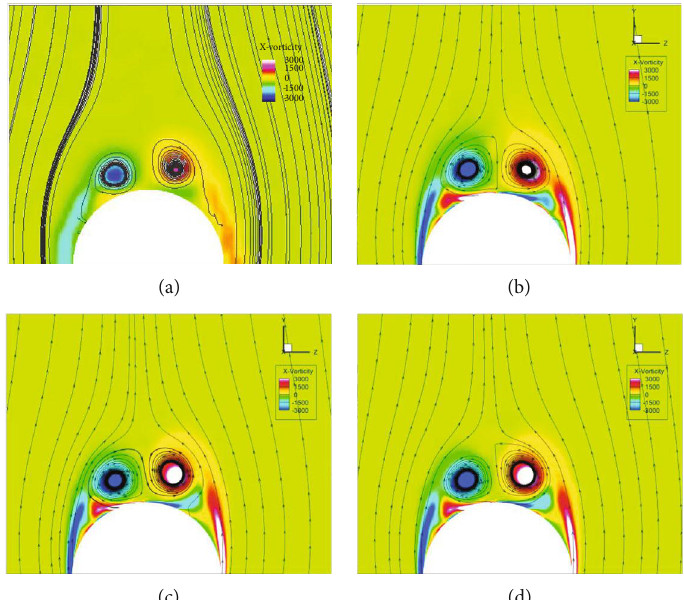
Figure 9: X -vorticity contour comparison at section 1: (a) PIV experiment, (b) result of Grid 1, (c) result of Grid 2, and (d) result of Grid 3.